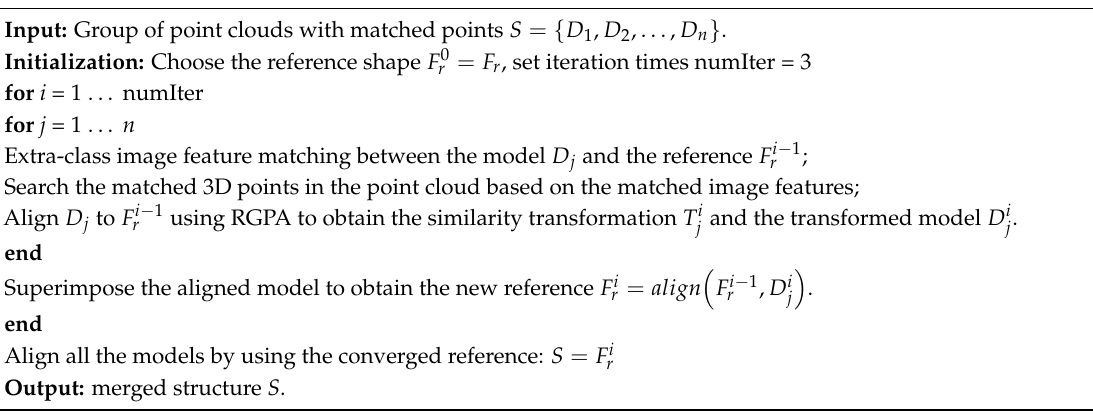
Algorithm 1. RANSAC generalized Procrustes analysis for point cloud alignment.